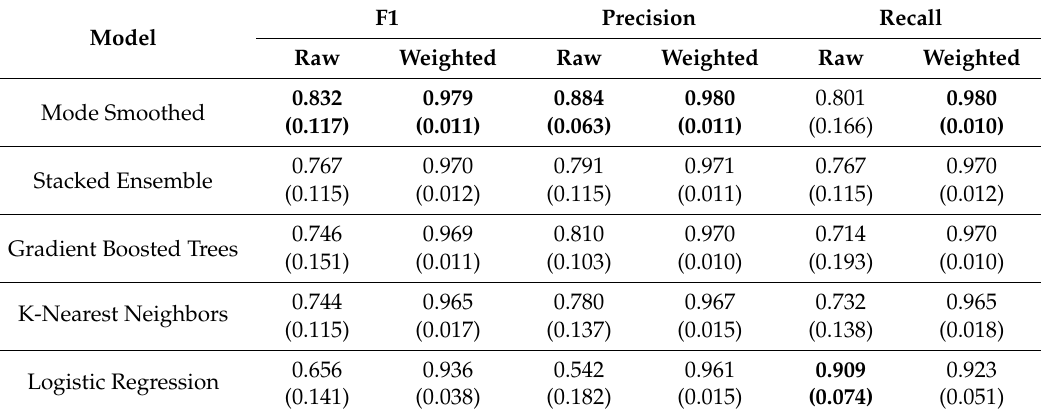
Table 2. Model evaluation metrics for each model. The numbers reported are the mean and standard deviation across the 21 LOSO CV hold-out folds [mean (std)] for both weighted and unweighted metric variants. The best results per metric are presented in bold. F1 Precision Model